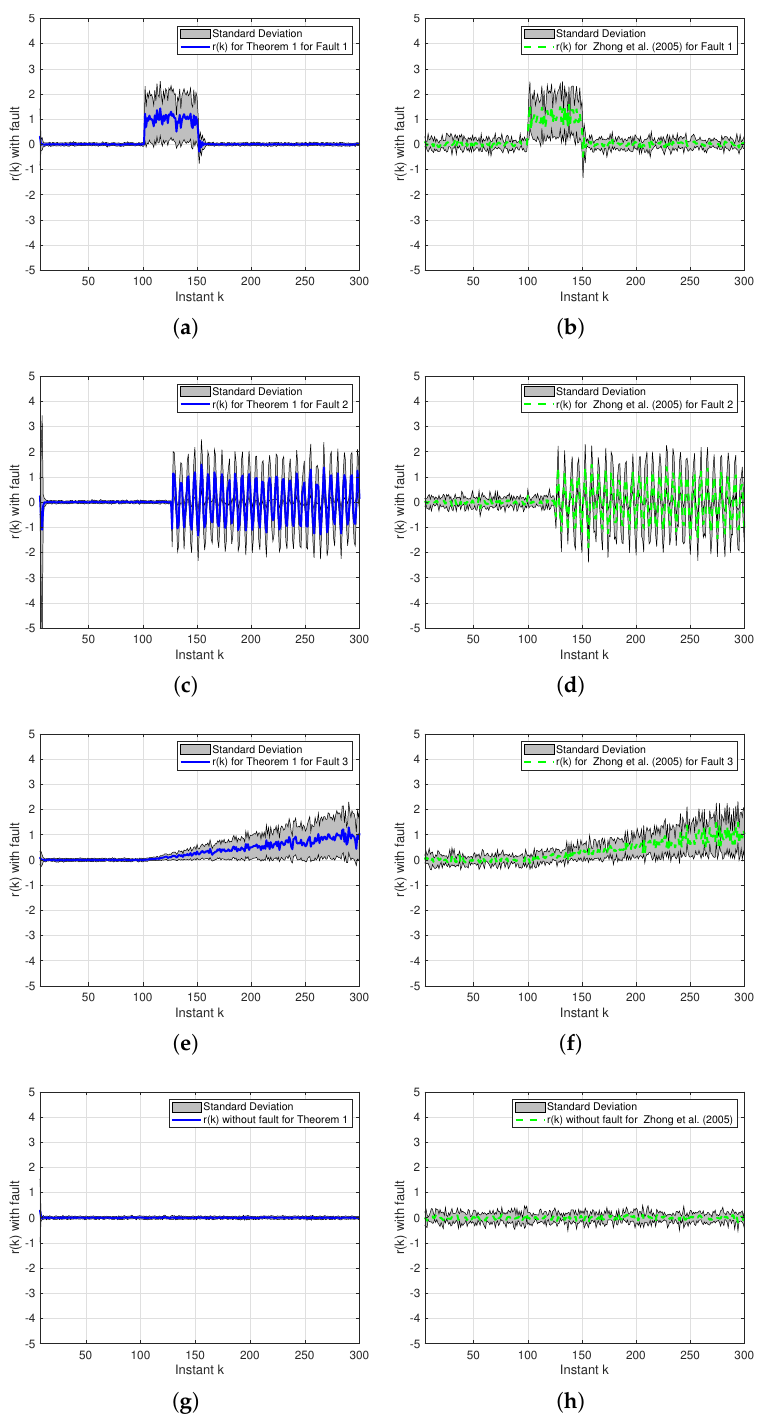
Figure 7. The residue signal obtained for FDF designed by using Theorem 1 under the assumption of knowledge of all modes (to the left), and the FDF provided by [8] (to the right). Both designs are subjected to three type of faults, and also the situation without fault. ( a ) Residue signal for FDF designed via Theorem 1 subjected to Fault 1. ( b ) Residue signal for FDF designed via [8] subjected to Fault 1. ( c ) Residue signal for FDF designed via Theorem 1 subjected to Fault 2. ( d ) Residue signal for FDF designed via [8] subjected to Fault 2. ( e ) Residue signal for FDF designed via Theorem 1 subjected to Fault 3. ( f ) Residue signal for FDF designed via [8] subjected to Fault 3. ( g ) Residue signal for FDF designed via Theorem 1 without fault. ( h ) Residue signal for FDF designed via [8] without